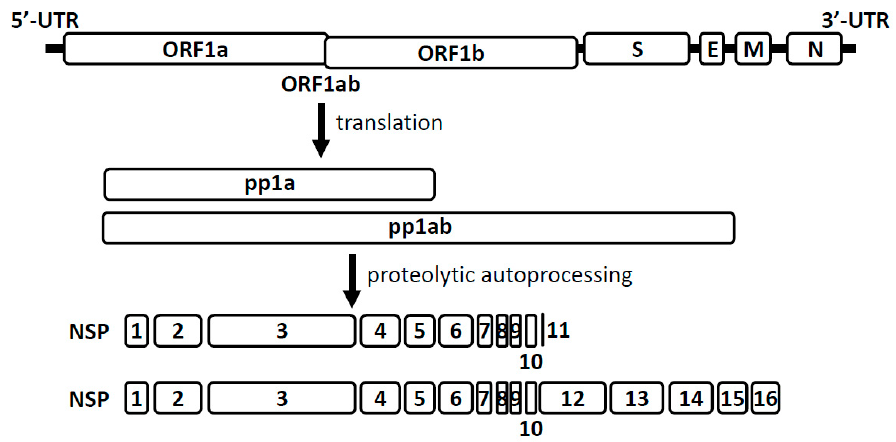
Figure 1. Genomic organization of representative human coronaviruses. E: envelope, M: mem- brane, N: nucleocapsid, NSP: nonstructural proteins, ORF: open reading frames, S: spike, UTR: untranslated region.